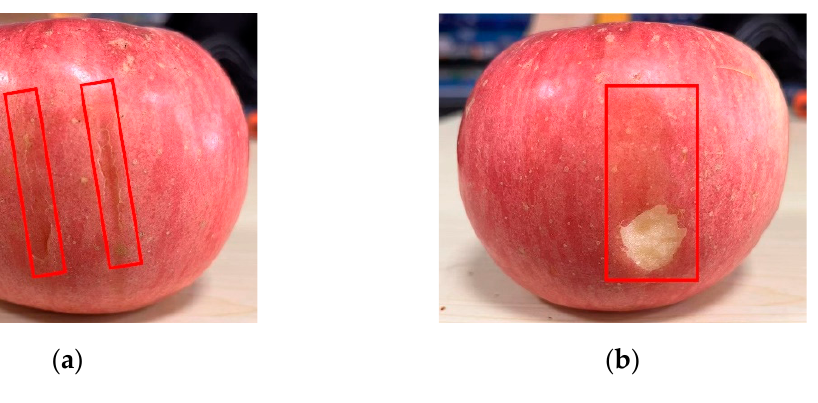
Figure 11. Damage to the fruit: ( a ) scratches; ( b ) bruises.